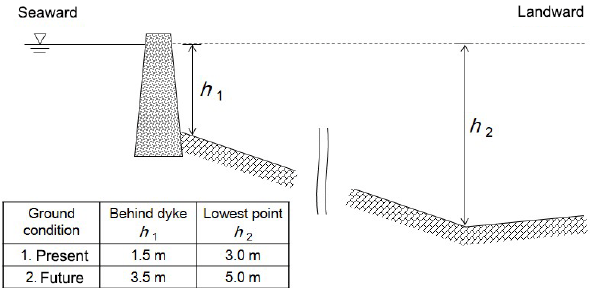
Figure 6. Schematic view of the topography considered in the numerical simulation. Scenario 1: present topography constructed based on the authors’ recent surveys. Scenario 2: future topography after experiencing an additional 2m land subsidence. h 1 denotes the height from the water level behind the dyke, h 2 the height at the lowest location in the district of